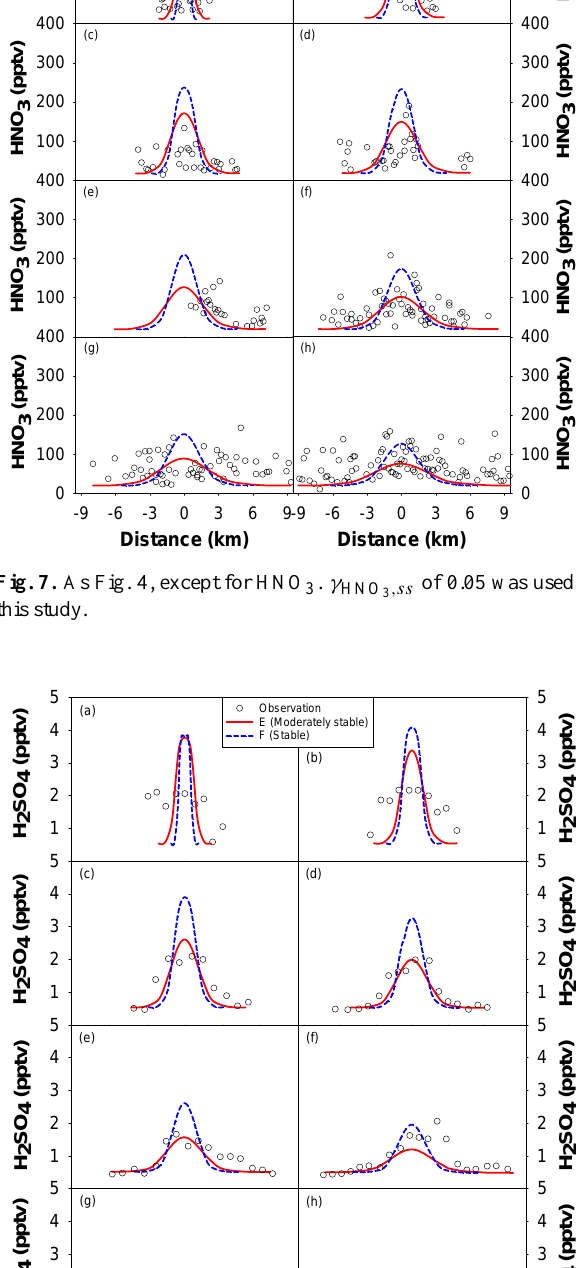
Fig. 8. As Fig. 4, except for H 2 SO 4